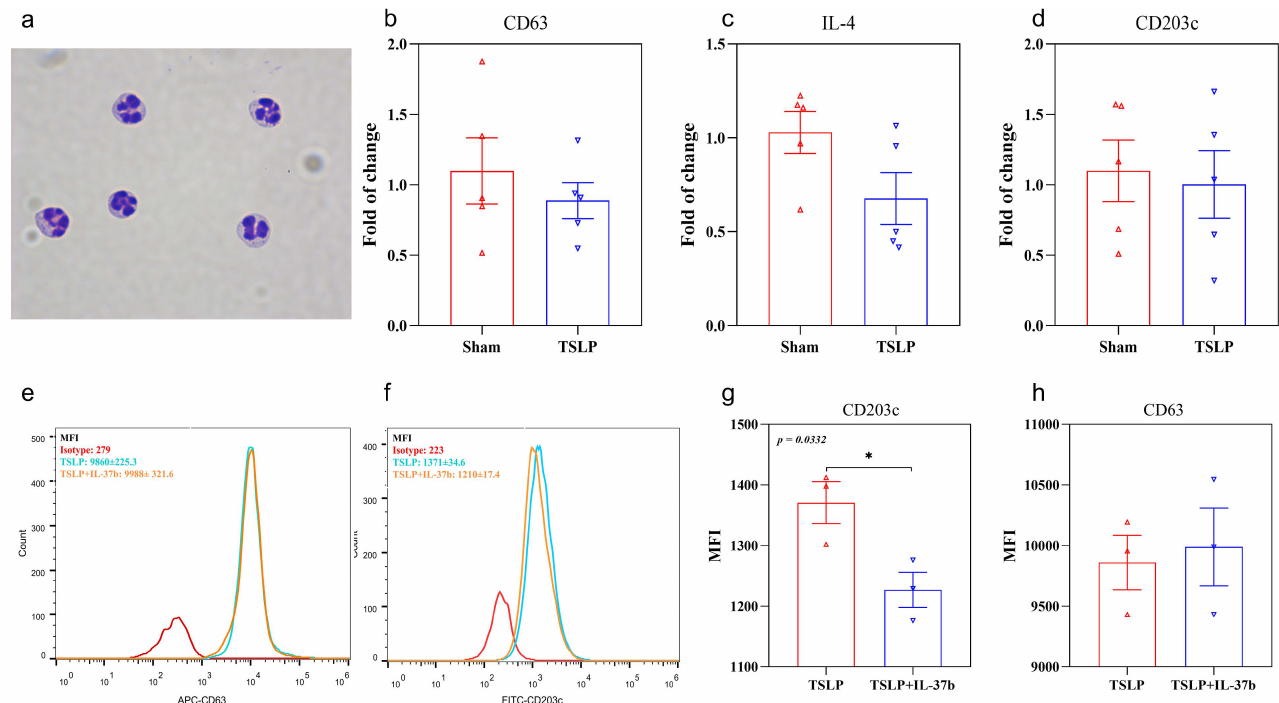
Figure 2. Effects of IL-37b on the expression of basophil activation markers and IL-4 by qPCR. ( a ) Basophils isolated from human PBMC; ( b – d ) qPCR quantitative analysis of CD63, IL-4 and CD203c; ( e , f ) flow cytometry analysis of CD63 and CD203c; ( g , h ) quantitative flow cytometry analysis of CD63 and CD203c. Bar charts are shown as mean ± SEM of n = 3 or 5. * p < 0.05 when compared between the